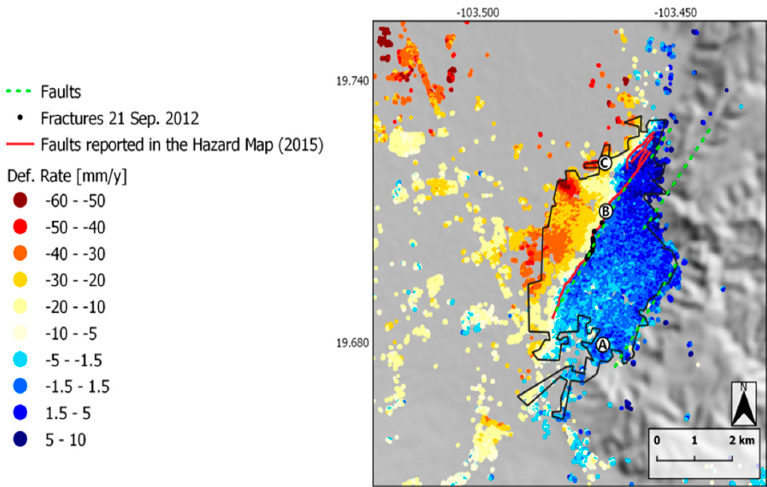
Figure 15. Overlay between S1 velocity map (ascending, values are expressed in [mm / year]) the fault mapped by the 2015 Development Plan (Government of the Municipality of Zapotlan el Grande [35]). The black lines are the faults traced in the framework of the “development map of the sub-district affected by the fault”.